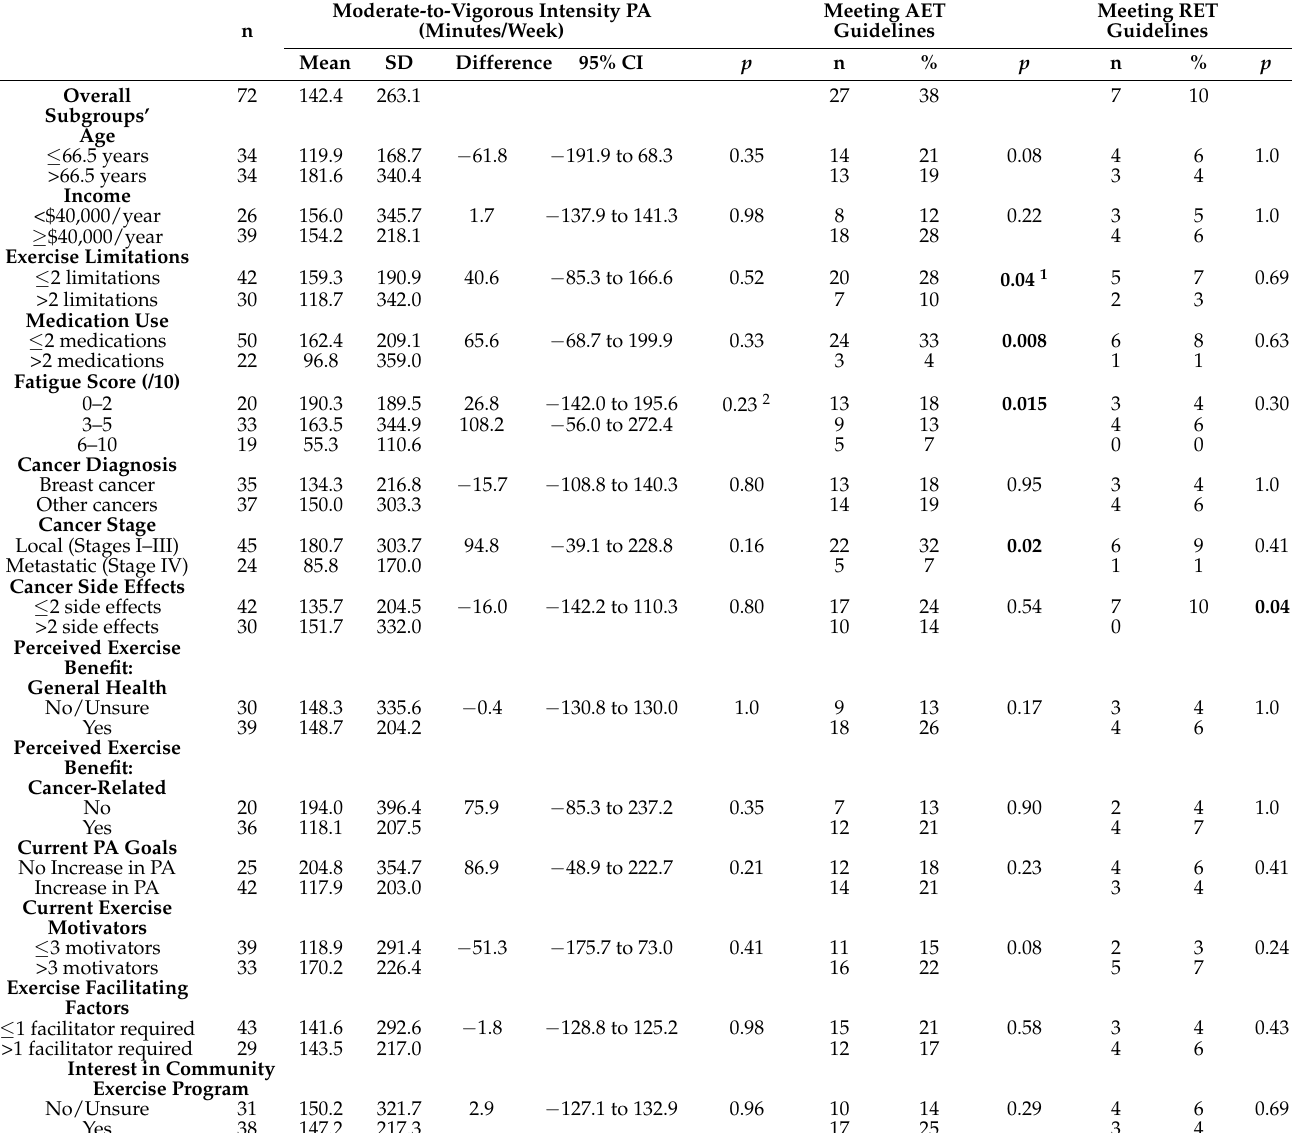
Table 3. Exercise engagement overall and by subgroups of rural cancer